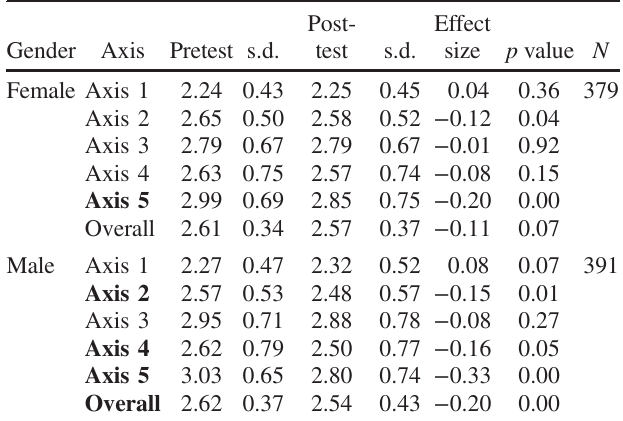
TABLE VII. EBAPS Modified spring pretest and post-test results by degree. a